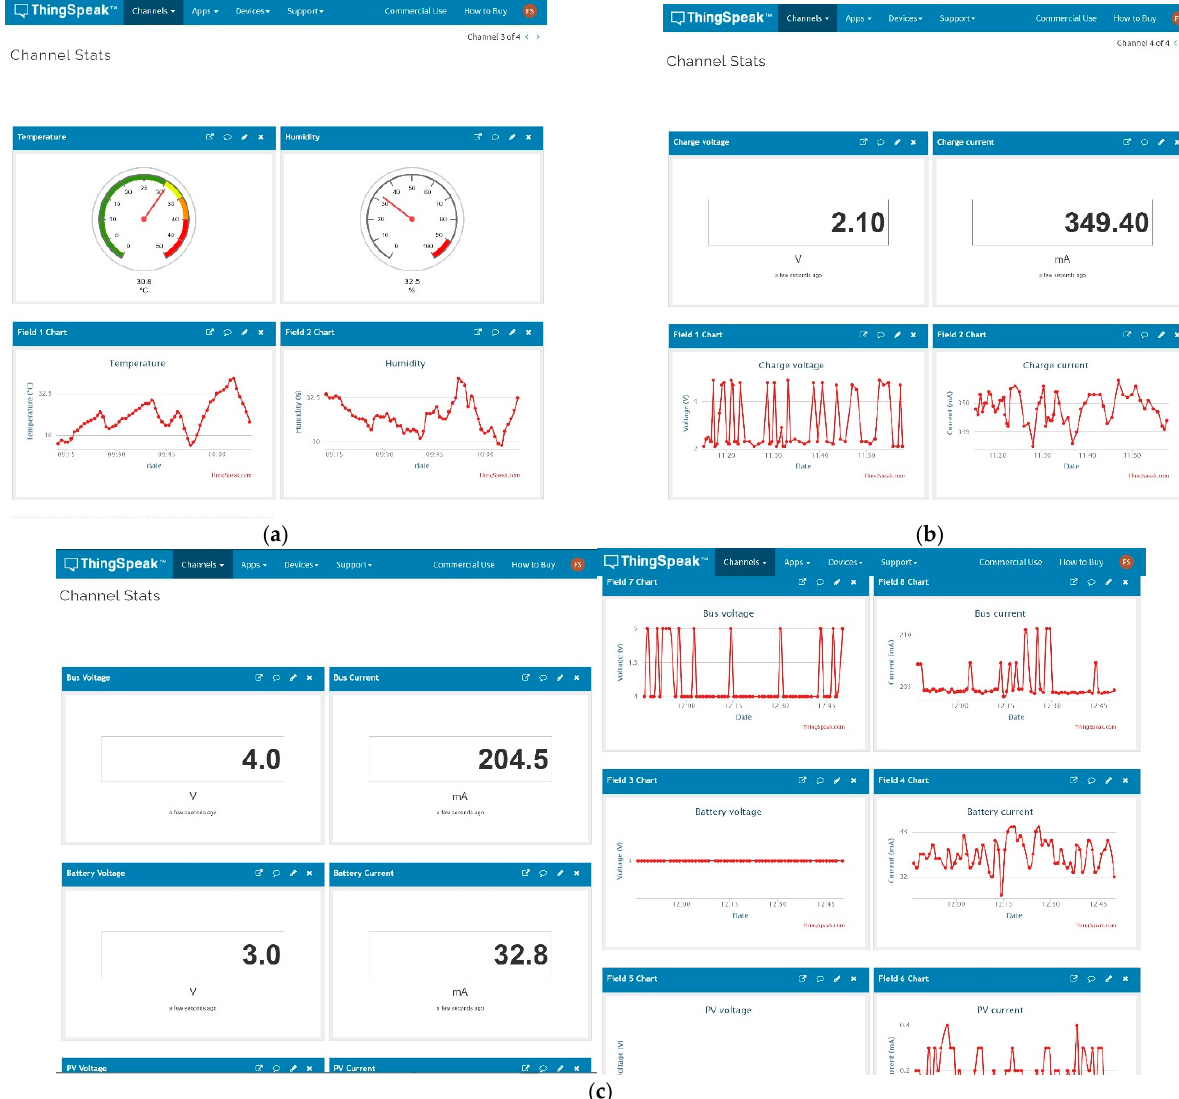
Figure 26. ThingSpeak Integration: ( a ) temperature and humidity data; ( b ) battery USB charge; and ( c ) THMDL battery power supply operation.